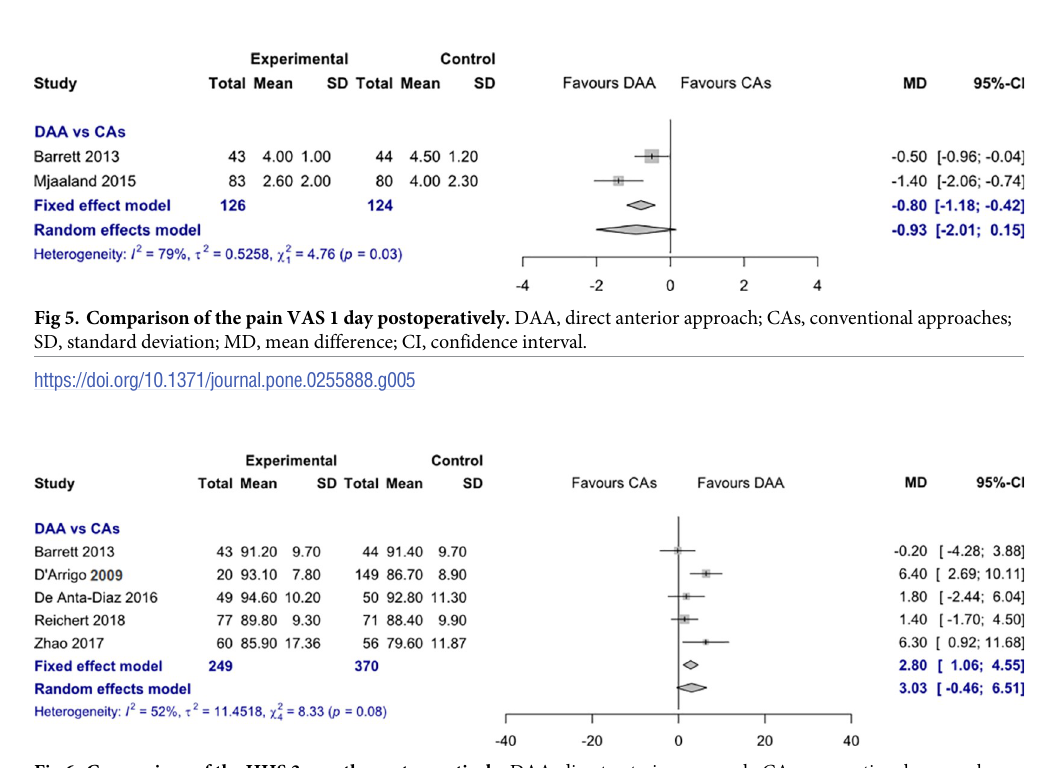
Fig 6. Comparison of the HHS 3 months postoperatively. DAA, direct anterior approach; CAs, conventional approaches; SD, standard deviation; MD, mean difference; CI, confidence interval.